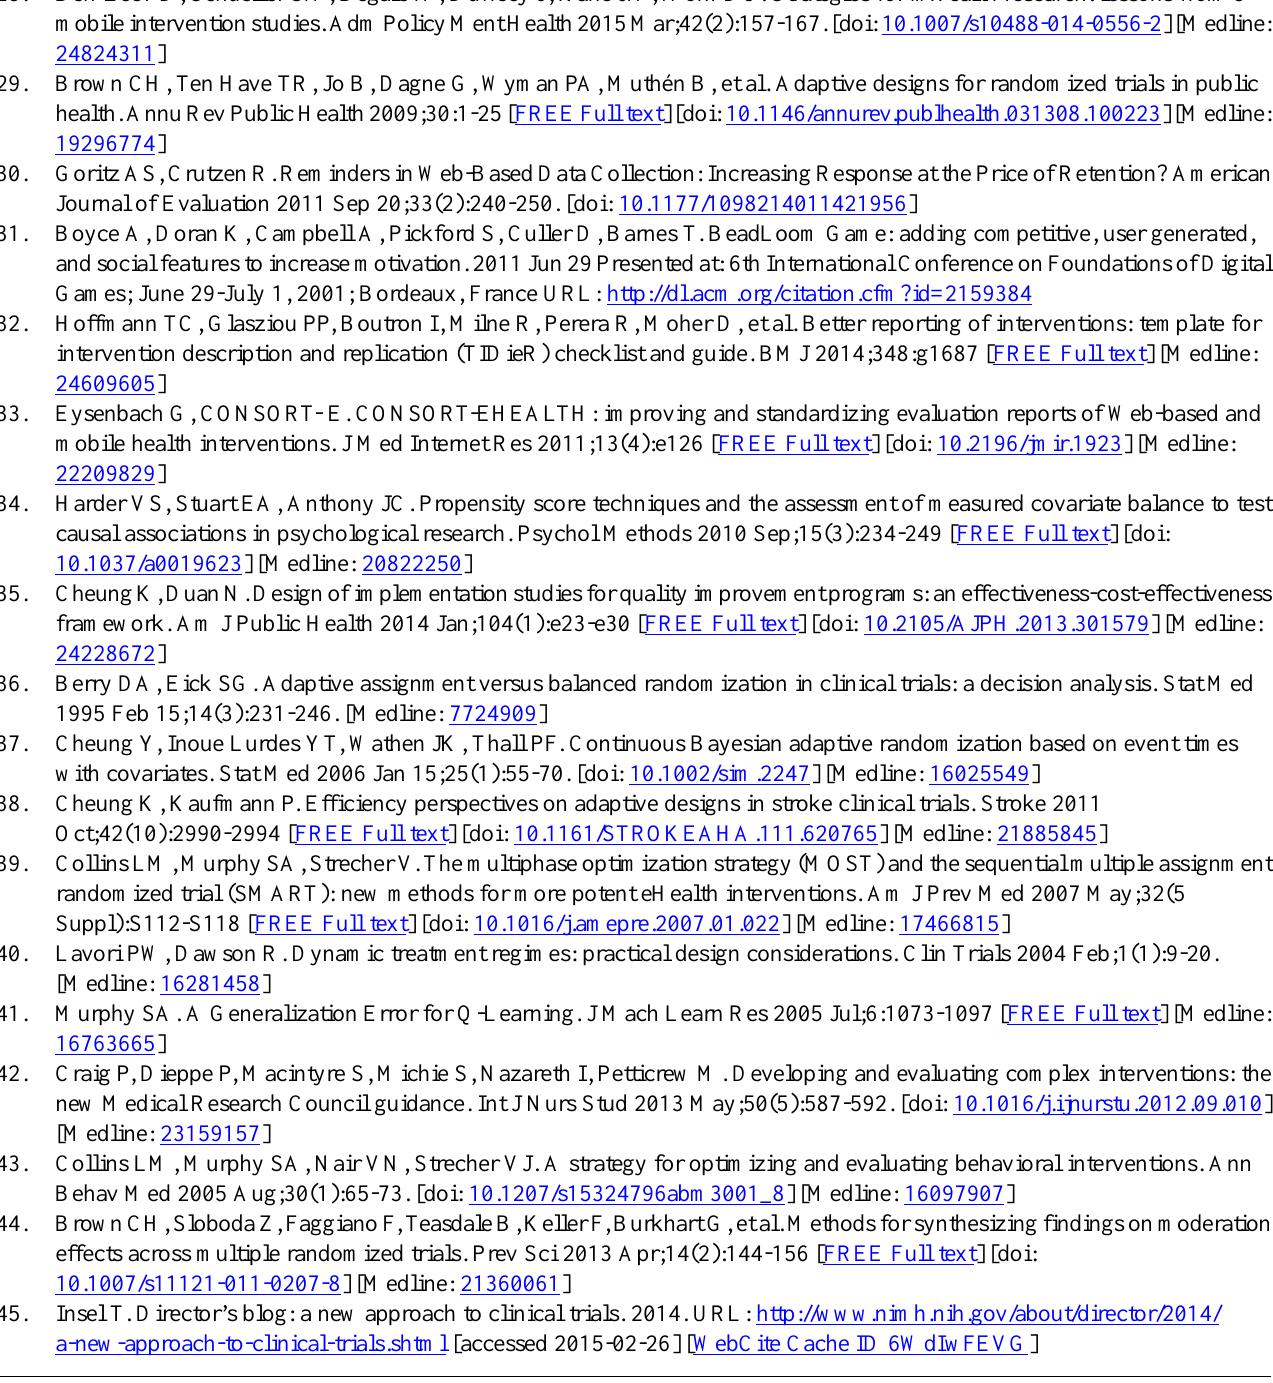
Abbreviations BIT: behavioral intervention technology RCT: randomized controlled trial SMART: sequential multiple assignment randomized trial TIP: trial of intervention